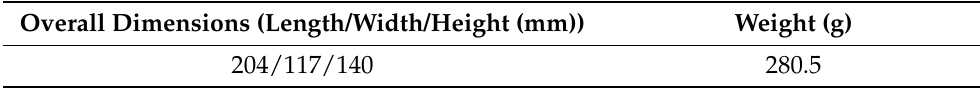
Figure 6. Measurement of axle weight of the miniature tractor: ( a ) Front axle; ( b ) Rear axle. Table 2. Specifications of the miniature tractor.